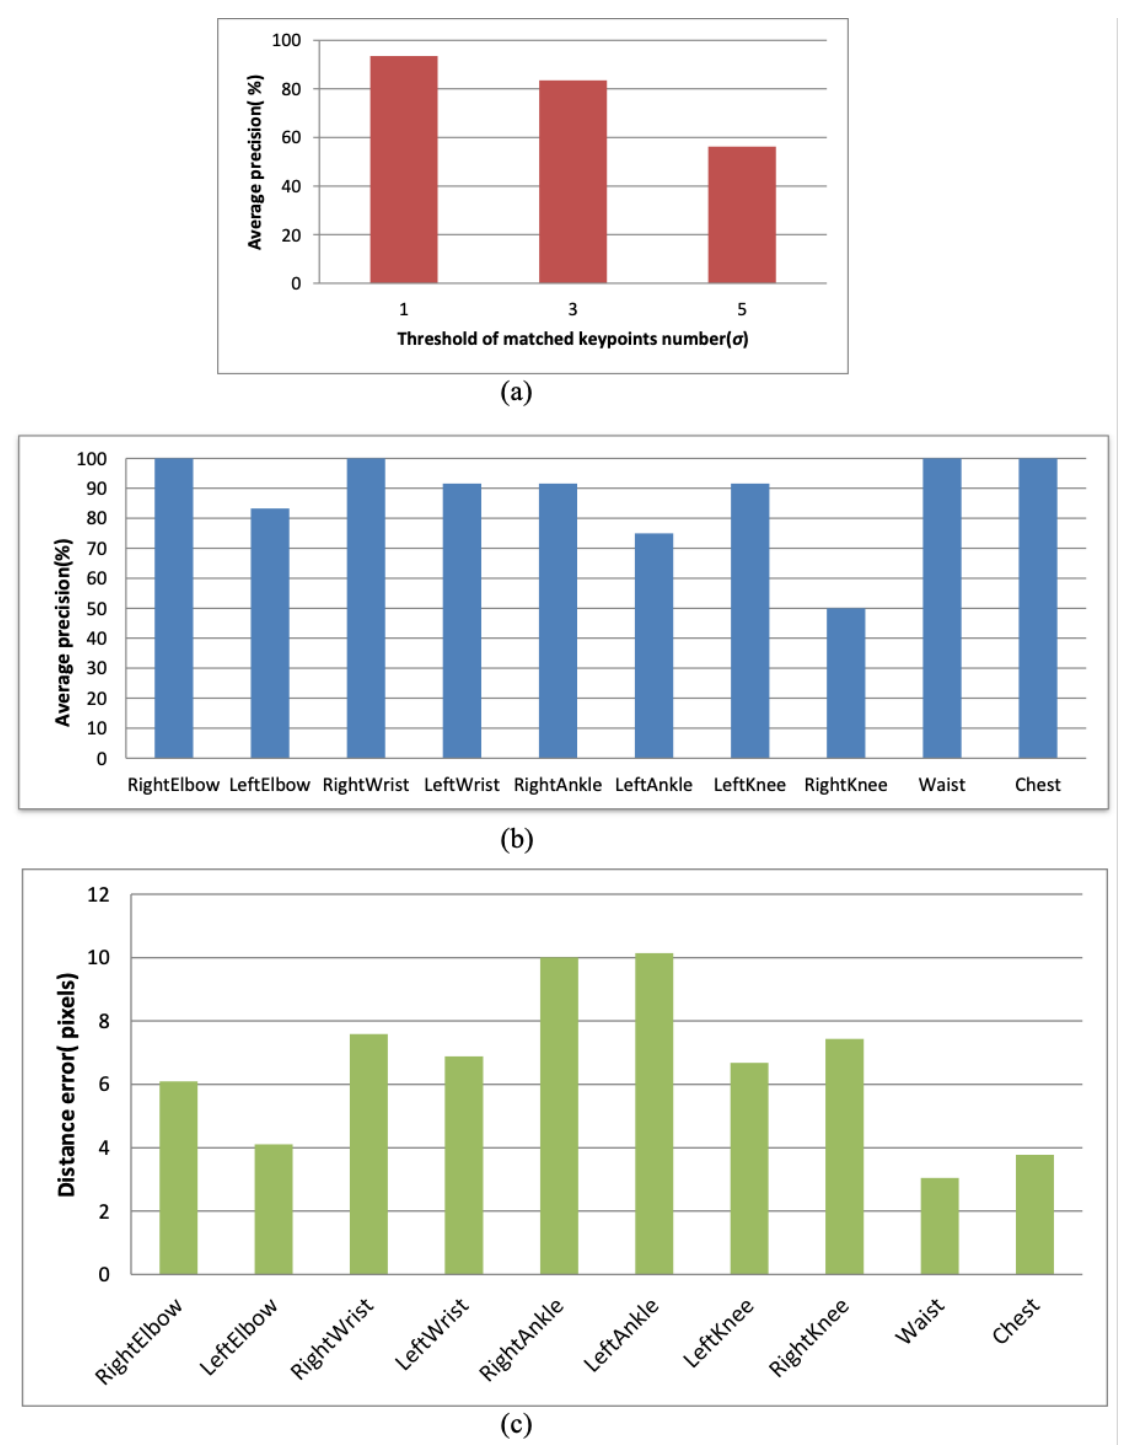
Figure 8. Accuracy evaluation. ( a ) The effect of the threshold of matched keypoint numbers. ( b ) Average precision of joint localization. ( c ) Average distance error of joint